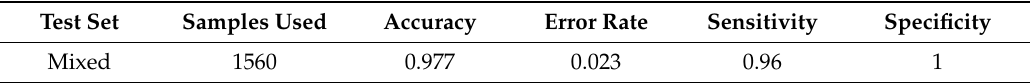
Table 2. Classification parameters from the test data set.